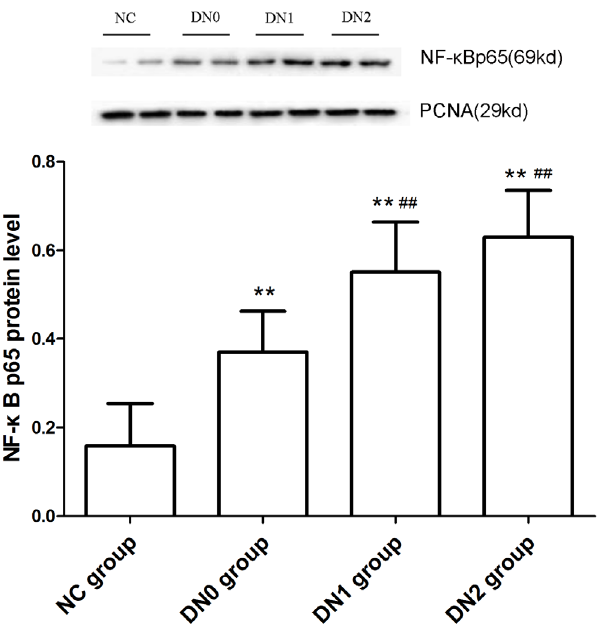
Figure 1. Nuclear NF- k B p65 protein level in peripheral blood mononuclear cells determined by western blotting. Note: Compared with NC group **: P , 0.01; compared with DN0 group ## : P , 0.01.